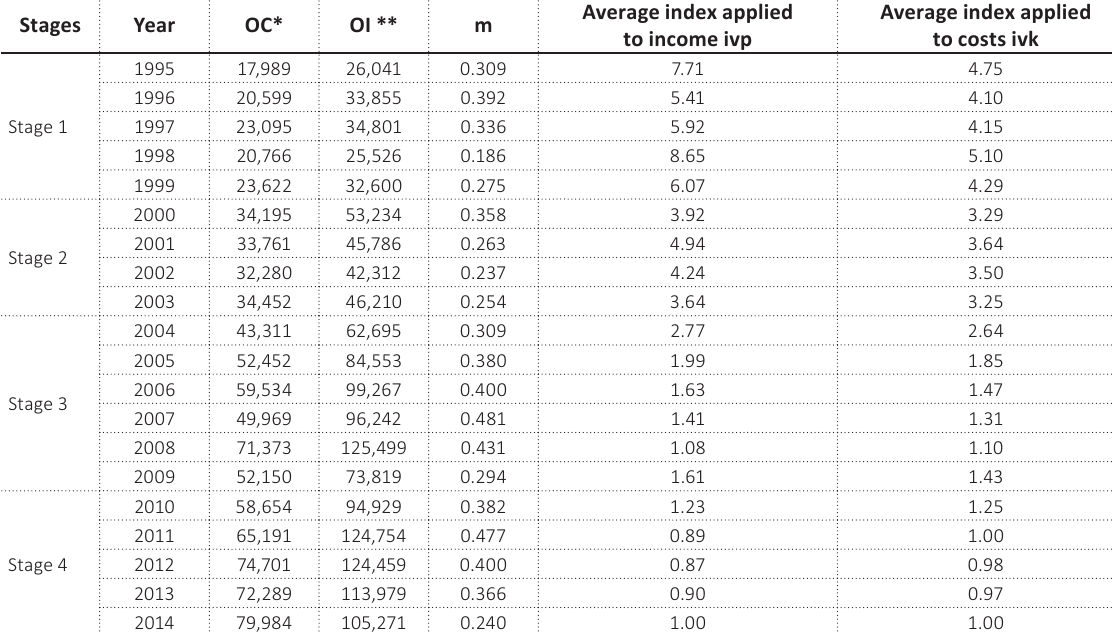
Table 3. PDVSA operation income and costs